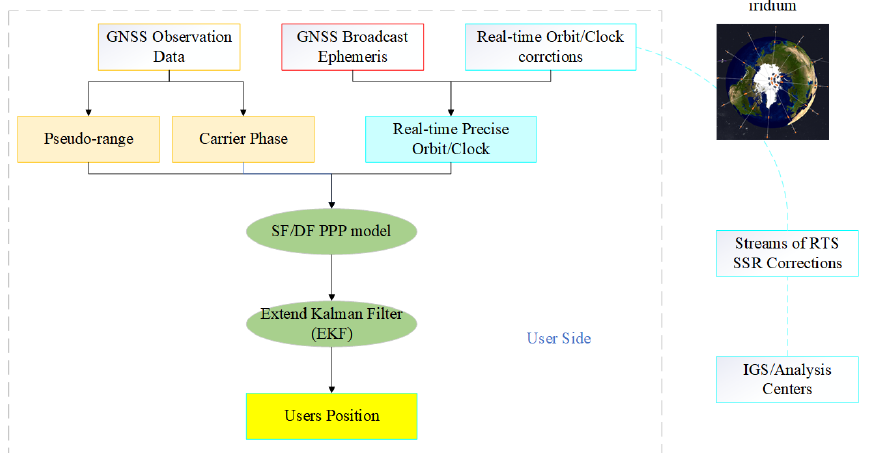
Figure 1. Flow chart of RT–PPP method in Northeast Passage.